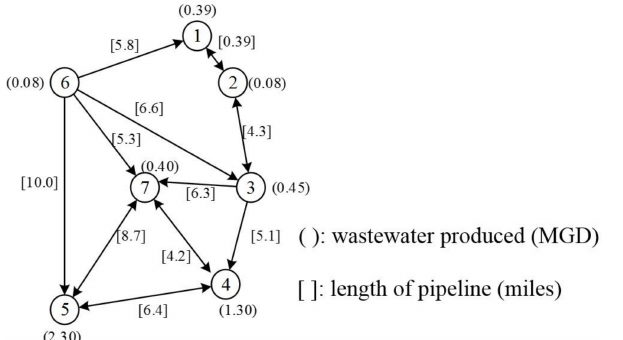
Figure 1. Locations of wastewater treatment plants and pipeline distribution in the case